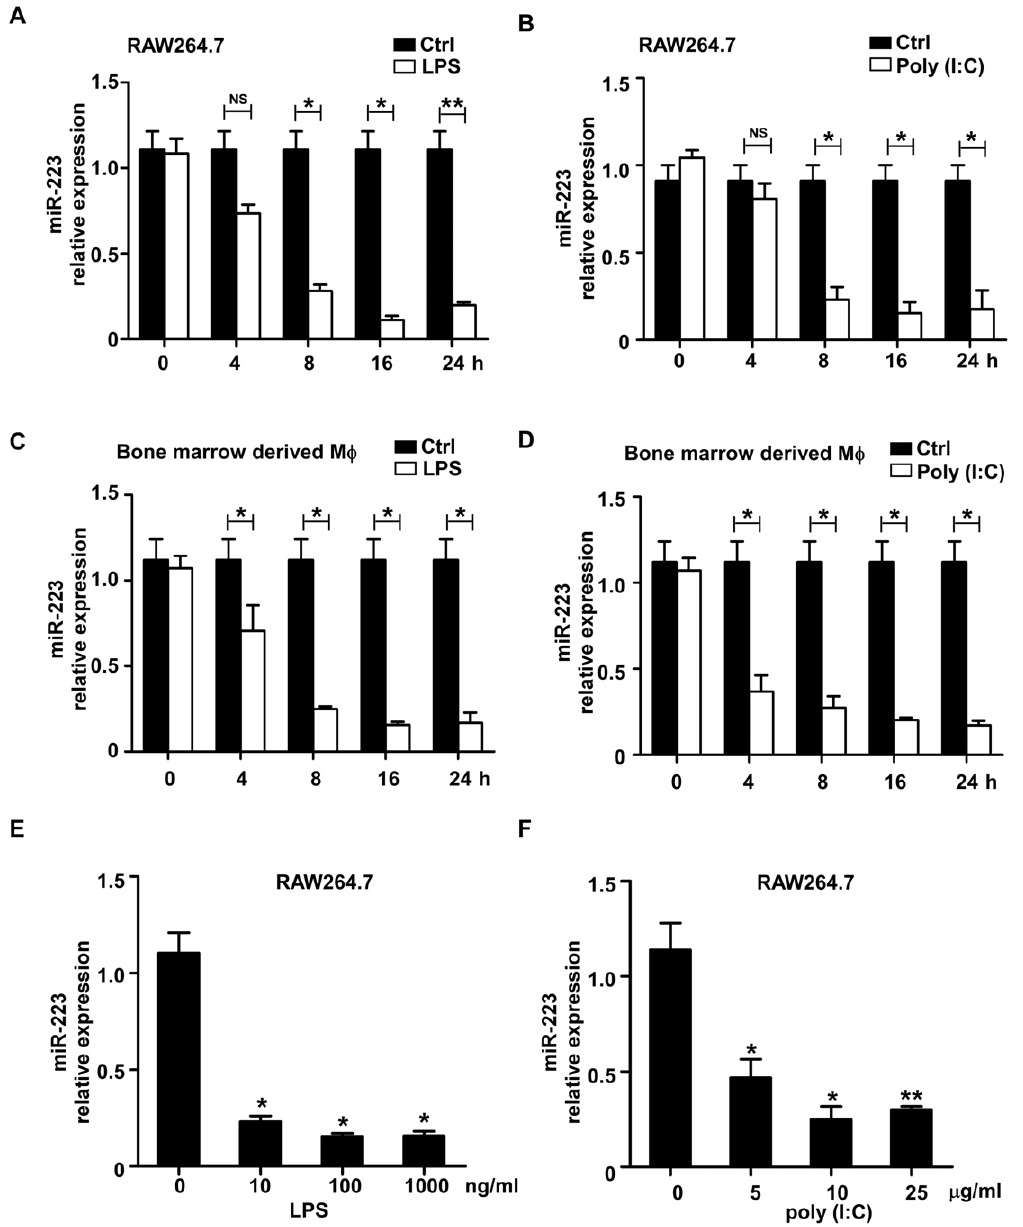
Figure 1. Down-regulation of miR-223 expression in RAW264.7 cells and primary macrophages stimulated with TLR agonists. (A–D) RAW264.7 and bone marrow-derived macrophages were stimulated with 100 ng/ml LPS or 10 m g/ml poly (I:C) for the indicated time points. The expression of miR-223 was measured by q-PCR and normalized to the expression of U6. (E–F) RAW264.7 cells were stimulated with different concentrations of LPS (E) or poly (I:C) (F) for 24 h. The expression of miR-223 was determined by qPCR and normalized to the expression of U6. Data are the mean 6 SD (n=3) of three independent experiments. *** p , 0.001; ** p , 0.01; * p , 0.05. doi:10.1371/journal.pone.0042971.g001 STAT3-specific small interfering RNA (siRNA). The siRNA down-regulated STAT3 protein level in RAW264.7 cells (Fig. 6A) and markedly inhibited LPS- or poly (I:C)-induced mRNA and protein expression of IL-6 and IL-1 b , but not TNF- a (Fig. 6B–F). The result was consistent with the effect of miR-223 over-expression on cytokine production. However, we were unable to detect differences in the levels of p-I k B- a , p-ERK1/2 and p-P38 between WT and STAT3-knockdown macrophages (data not shown).